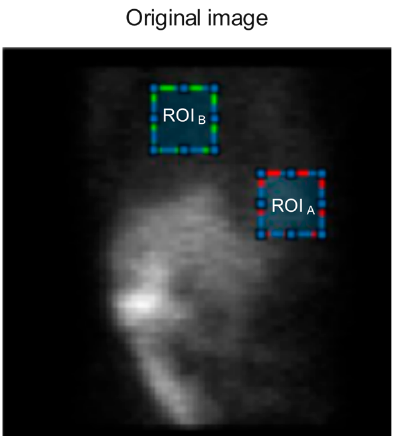
Figure 4. A SPECT image showing region of interest A ( ROI A ) with a highlighted red square, as well as the background region ( ROI B ) with a highlighted green square, for calculation of the signal-to-noise ratio (SNR) and contrast-to-noise ratio (CNR) indicators.